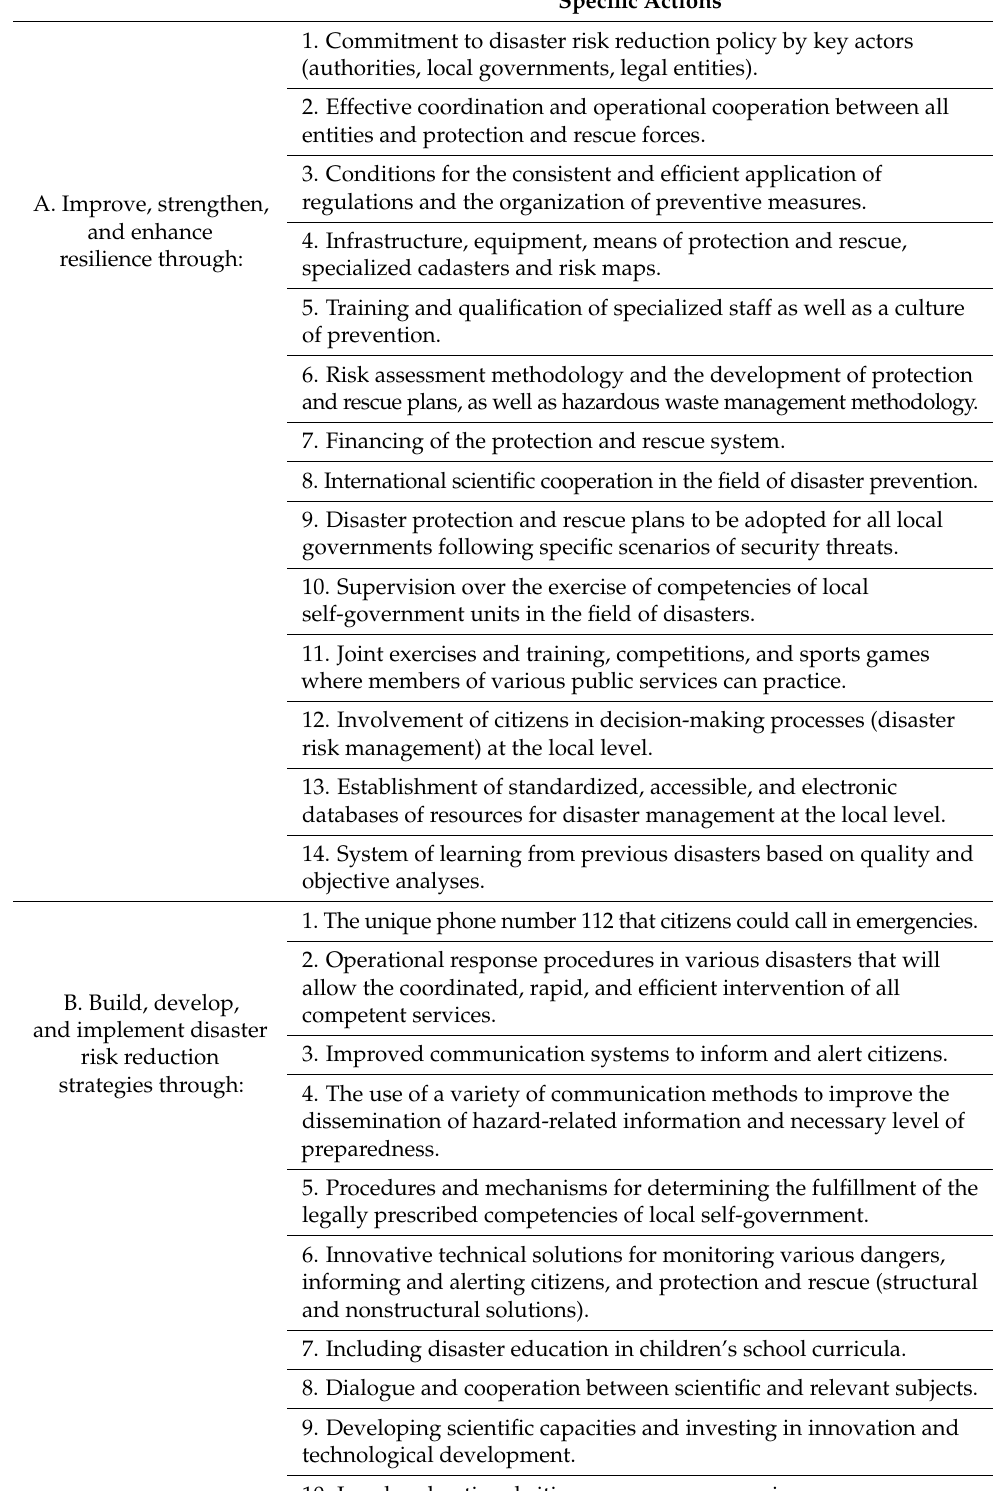
Table 8. Recommendations for improving the situation in the field of disaster risk management in